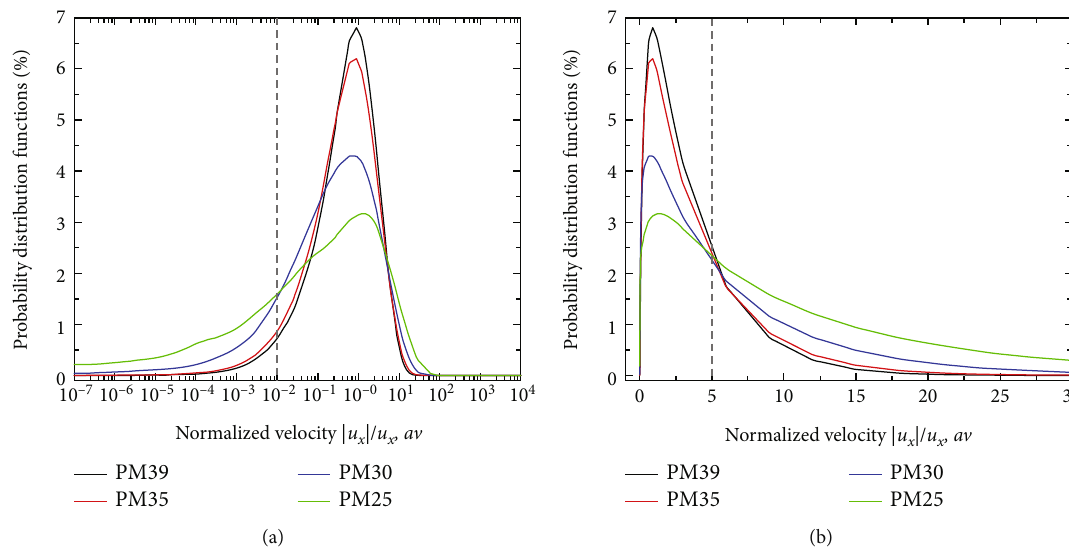
Figure 6: Probability distribution functions (PDFs) of the velocities normalized by the average velocity in porous media with di ff erent cementation degrees (PM39, PM35, PM30, and PM25 representing porous media with porosities of 0.39, 0.35, 0.30, and 0.25, respectively). The PDFs are presented as (a) semilog plot and (b) decimal coordinate plot. Note: in the fi gure, the dashed lines in (a, b) signify the slow fl ow area criterion and fl ow focusing area criterion, respectively. ffi cient of variation CV Table 3: Standard variance σ u and the coe u of the fl ow velocity along the main fl uid fl ow direction; percentages of the fl ow focusing area P focus and percentages of the slow fl ow regions P slow in all the porous